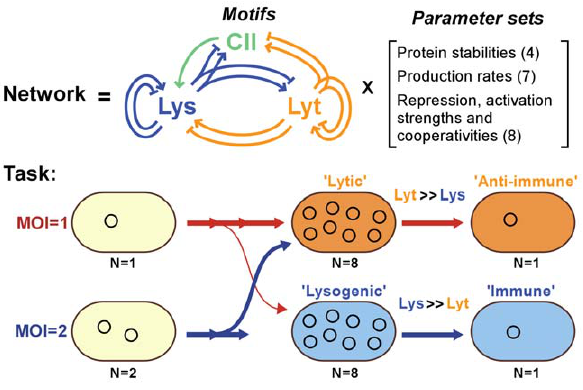
Figure 1. Construction and testing of in silico networks for performance in a l -like counting and memory task. Each network was a combination of a network motif and a random parameter set. Each motif was one of the 80 combinations of transcriptional inter- and auto-regulation by two proteins, Lys (lysogenic) and Lyt (lytic), with each regulatory link either activatory, repressive or absent. In the two-protein networks only Lys and Lyt are present; in the two-protein + CII networks, a l CII-like function was added. A set of 1 : 32 | 10 6 random parameter sets were generated and used in each network motif. In the deterministic counting and memory task, ‘infection’ by a single copy of the network followed by replication should always produce the ‘lytic’ (Lyt & Lys) outcome, while infection by two copies should always produce the reverse outcome. In the stochastic counting task, where noise is added, some transition from one pathway to the other is permitted. In both cases ‘memory’ is required; the lytic or lysogenic states should remain stable when the copy number is reduced to one.